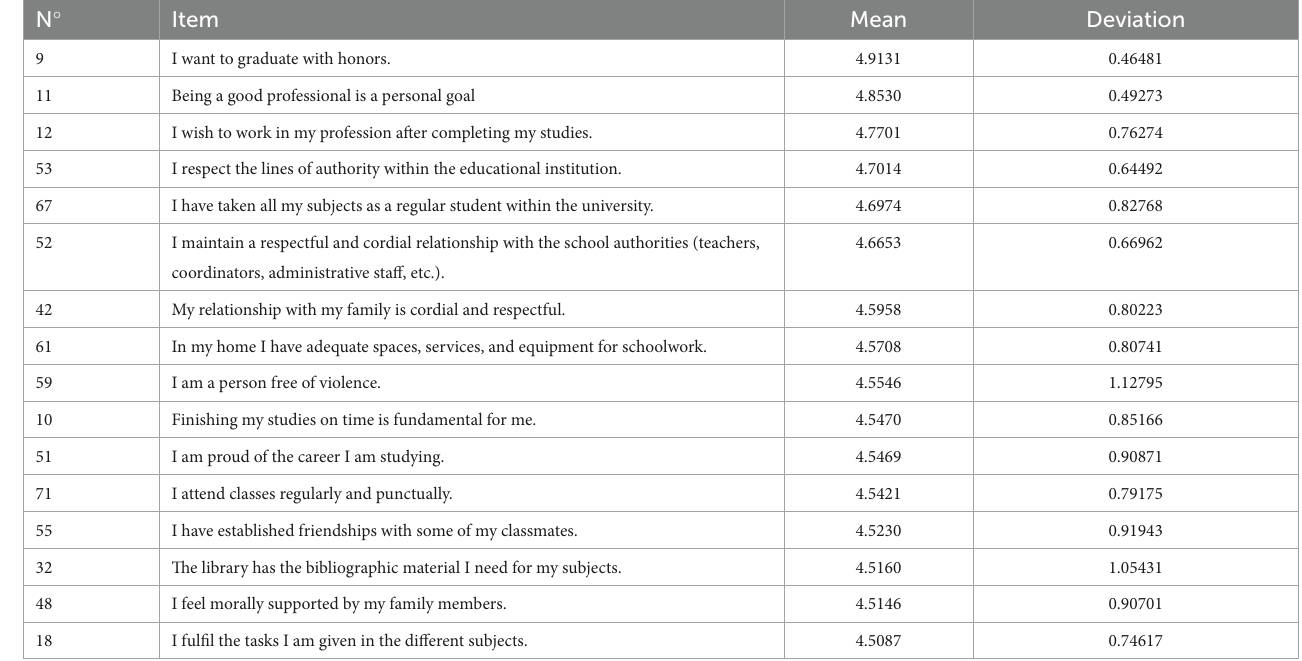
TABLE 5 Items with the highest scores in early childhood education and primary education